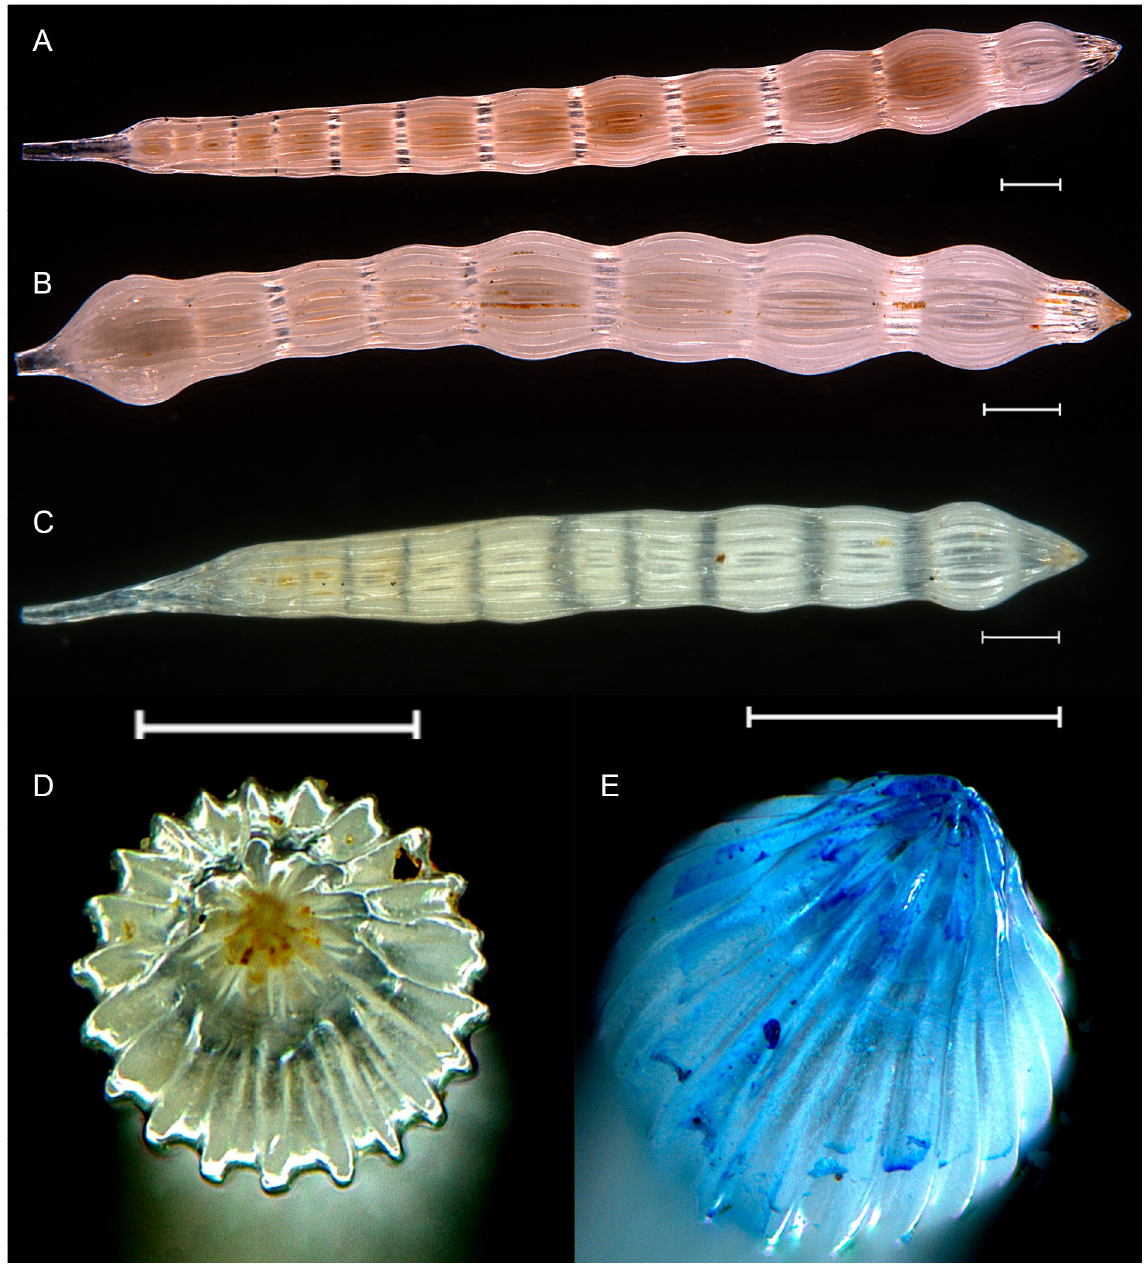
Fig. 7. Dentalina mutabilis (Costa, 1855). A . Megalosphere (BIOICE 3501, IINH 39299), side view. B . Megalosphere (BIOICE 3598, IINH 39281), variant with exceptionally large proloculus. C–E . Megalosphere (BIOICE 3280, IINH 39273), side view (C), aperture (D) and aperture (E) of the same specimen stained with indigo blue. Light source combination of incident light and dark field. Scale bars = 0.25